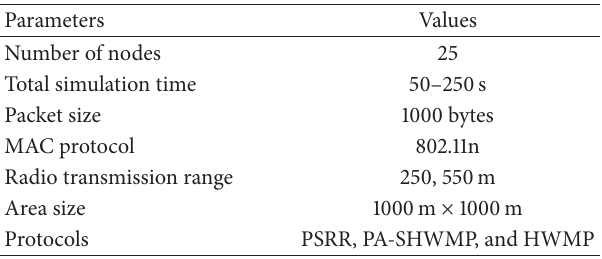
Table 1: Simulation parameters.